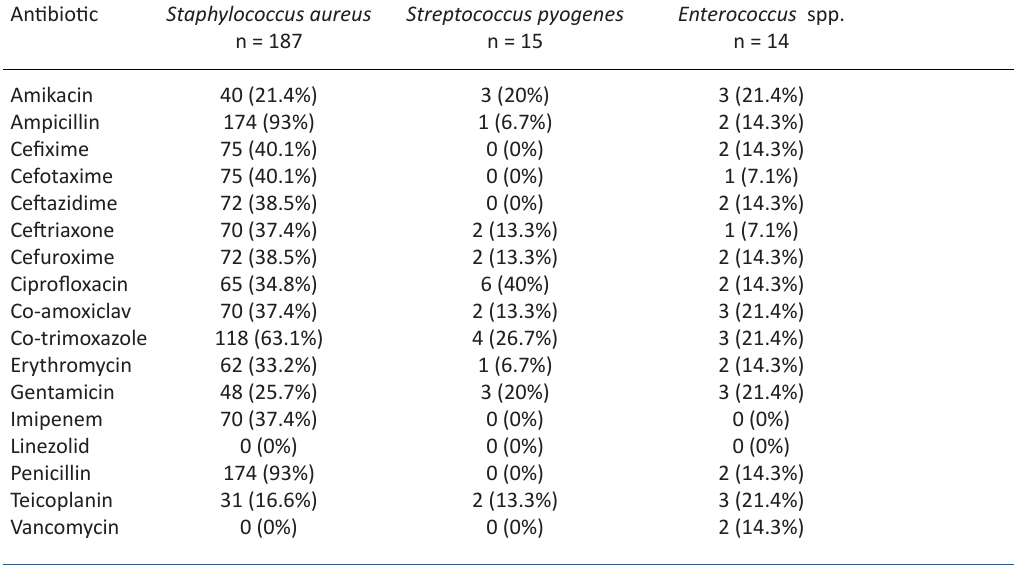
Table 3. Spectrum of drug resistance in Gram-positive bacterial pathogens (n = 216) Antibiotic Staphylococcus aureus Streptococcus pyogenes Enterococcus